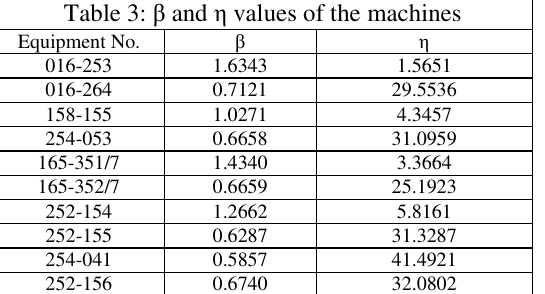
Fig. 5: Reliability curve Table 3: β and η values of the machines Equipment